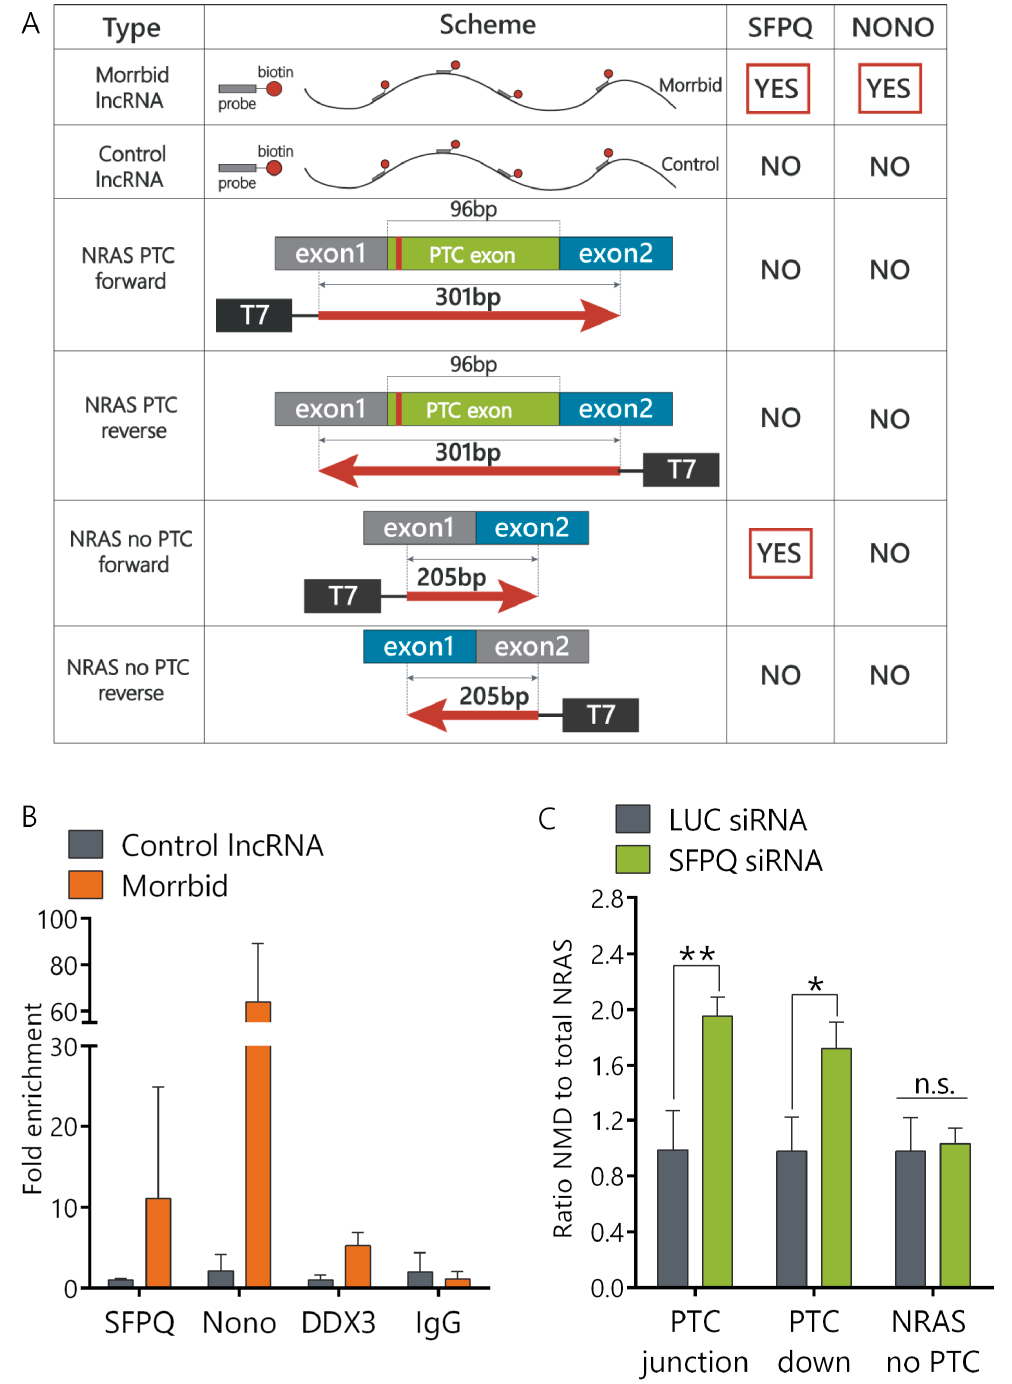
Figure 3. The SFPQ-NONO heterodimer interacts with Morrbid and influences NRAS PTC exon splicing. ( A ) Summary table of the Capture Hybridization Analysis of RNA Targets (CHART) and RNA pulldown assay results. ( B ) Fold enrichment of Morrbid lncRNA in the RNA immunoprecipitation assay (RIP) performed with SFPQ and NONO antibodies, as well as DDX3 and IgG antibodies as controls, quantified with RT-qPCR. ( C ) Relative expression of NRAS isoforms after 6 days of inhibition of the SFPQ protein (RT-qPCR analysis). siRNA: small interfering RNA. Results show mean ± SD. n.s.—not significant. * p < 0.05, ** p < 0.01.